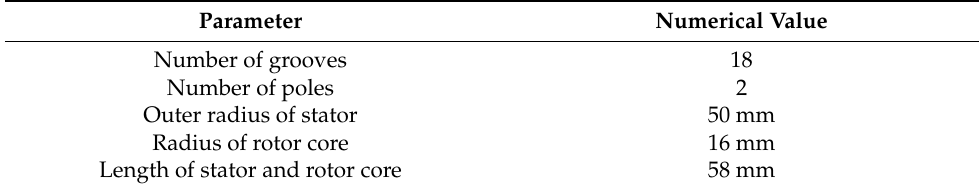
Figure 3. Structural diagram of 3D complete machine. Table 2. Main geometric parameters of